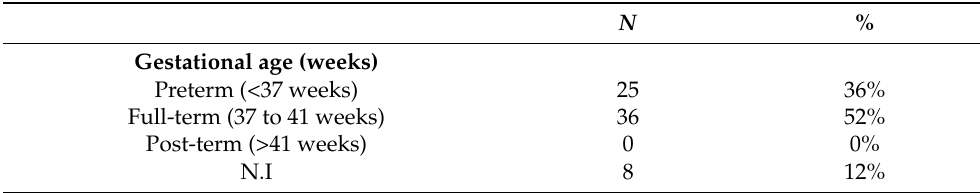
Table 1. Patient characteristics and risk factors for developing post-caesarean section surgical site infection by Acinetobacter